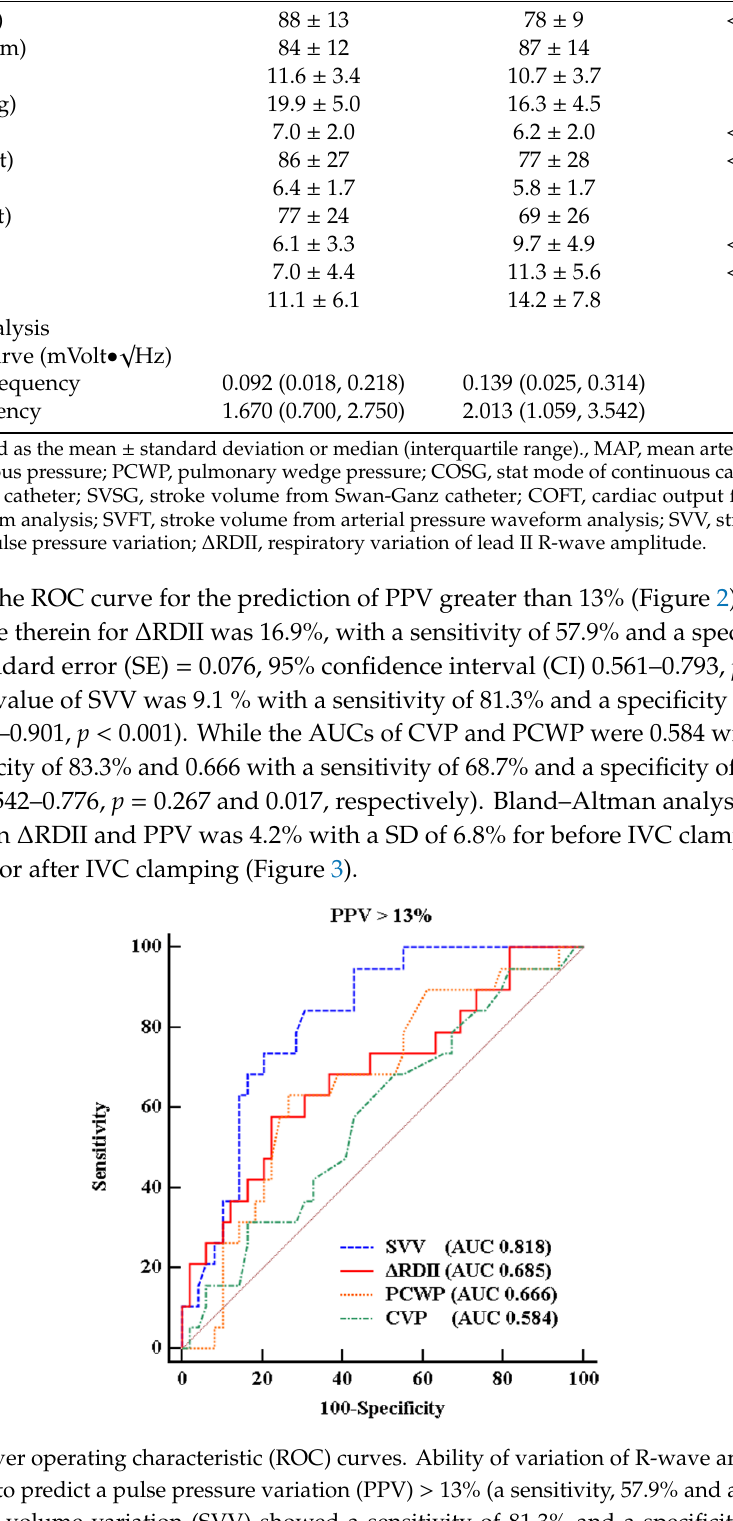
Figure 3. Bland – Altman analyses comparing variation of R- wave amplitude in lead II (ΔRDII) and pulse pressure variation (PPV) during before (a) and after (b) IVC clamping. The dotted lines represent the average difference between ΔRDII and PPV (i.e., bias) and the solid lines represent the upper and lower 95% confidence limits of agreement. At the time of IVC clamping, most patients (31/34) received continuous norepinephrine infusion. The patients were divided into two groups according to whether norepinephrine infusion dose was at least 0.1 µg/kg/min or not (Table 3 ). ΔRDII, SVV , PPV, and PCWP changed significantly when the norepinephrine dose less than 0.1 µg/kg/min or none. However, changes associated with a norepinephrine dose of more than 0.1 µg/kg/min were not statistically significant ( p = 0.093).